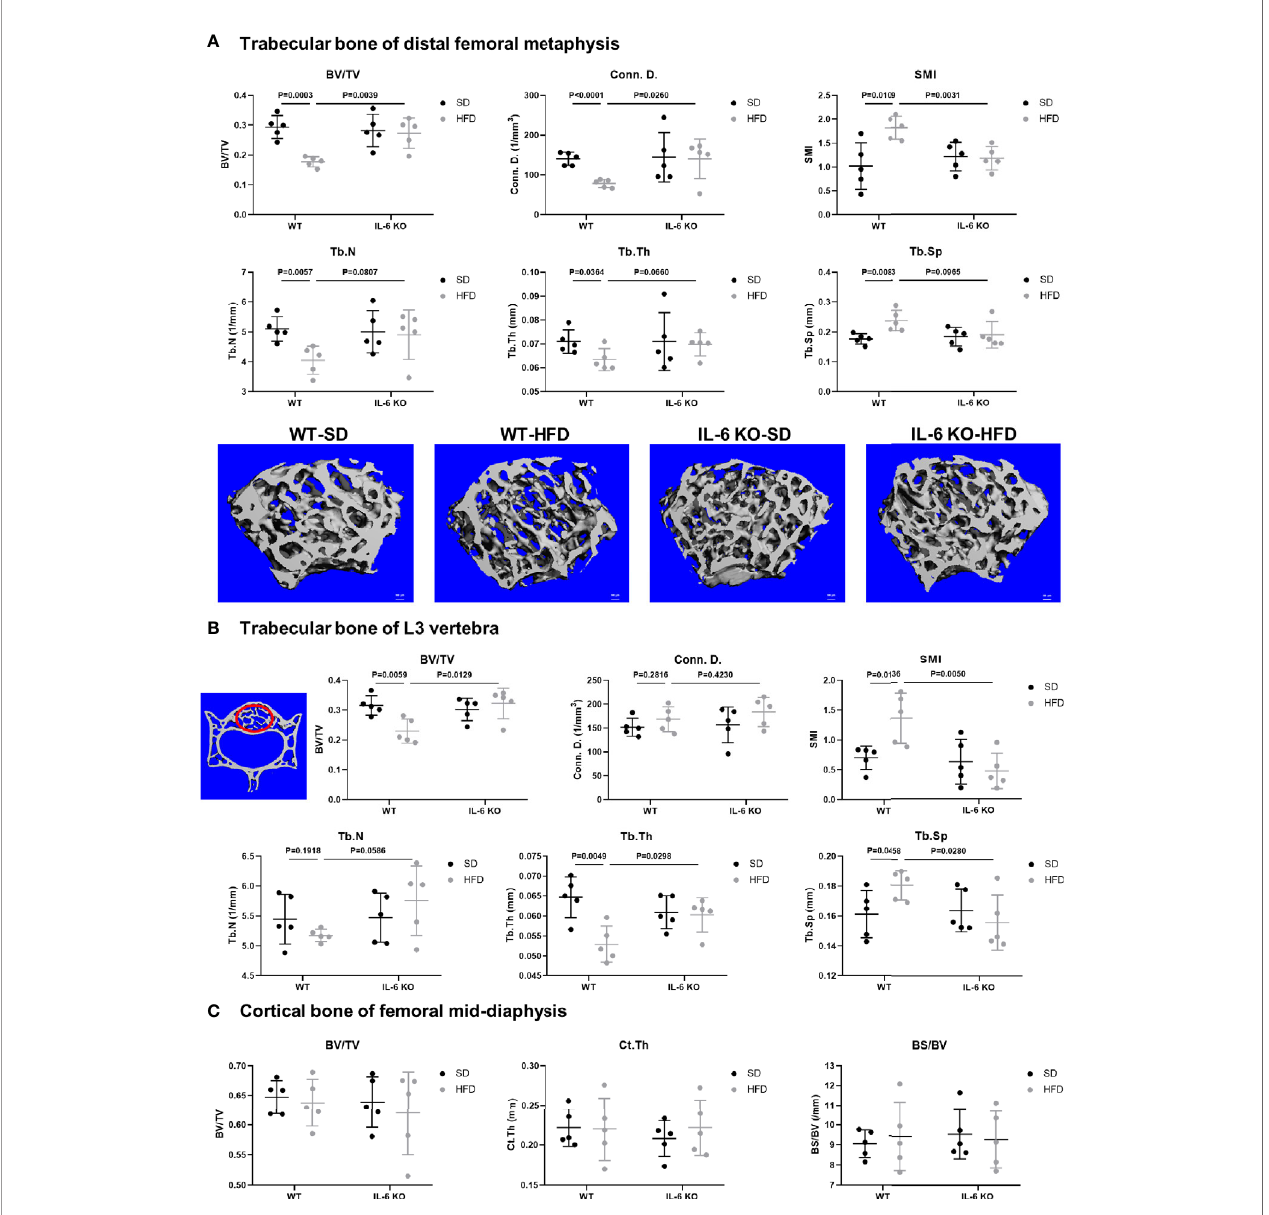
FIGURE 2 | IL-6 KO restrained the trabecular bone loss in HFD-induced obesity. (A) The trabecular bone parameters at distal femoral metaphysis were evaluated as BV/TV, Conn. D, SMI, Tb. N, Tb. Th and Tb. Sp from WT and IL-6 KO mice after SD or HFD treatment. Representative images for m CT 3D reconstruction were shown in lower panel (scale bar = 100 m m). (B) The trabecular bone parameters at the L3 vertebra were measured via m CT from WT and IL-6 KO mice after SD or HFD treatment. The red circles indicate the ROI. (C) The cortical bone parameters at femoral mid-diaphysis measurement were evaluated as BV/TV, Ct. Th and BS/ BV from WT and IL-6 KO mice after SD or HFD treatment. Data were expressed as mean ±